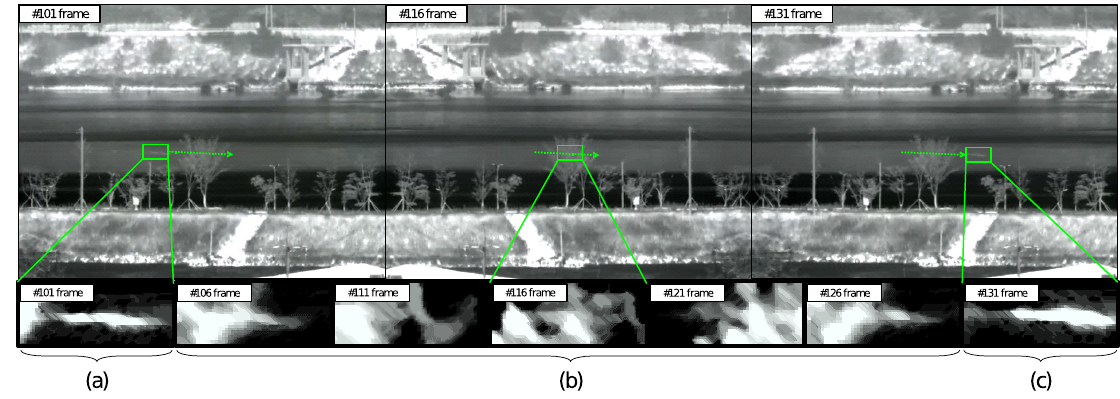
Figure 2. Drone detection using EO/IR imaging system at different background condition. ( a , c ) detection success in normal background, ( b ) detection fail in complex